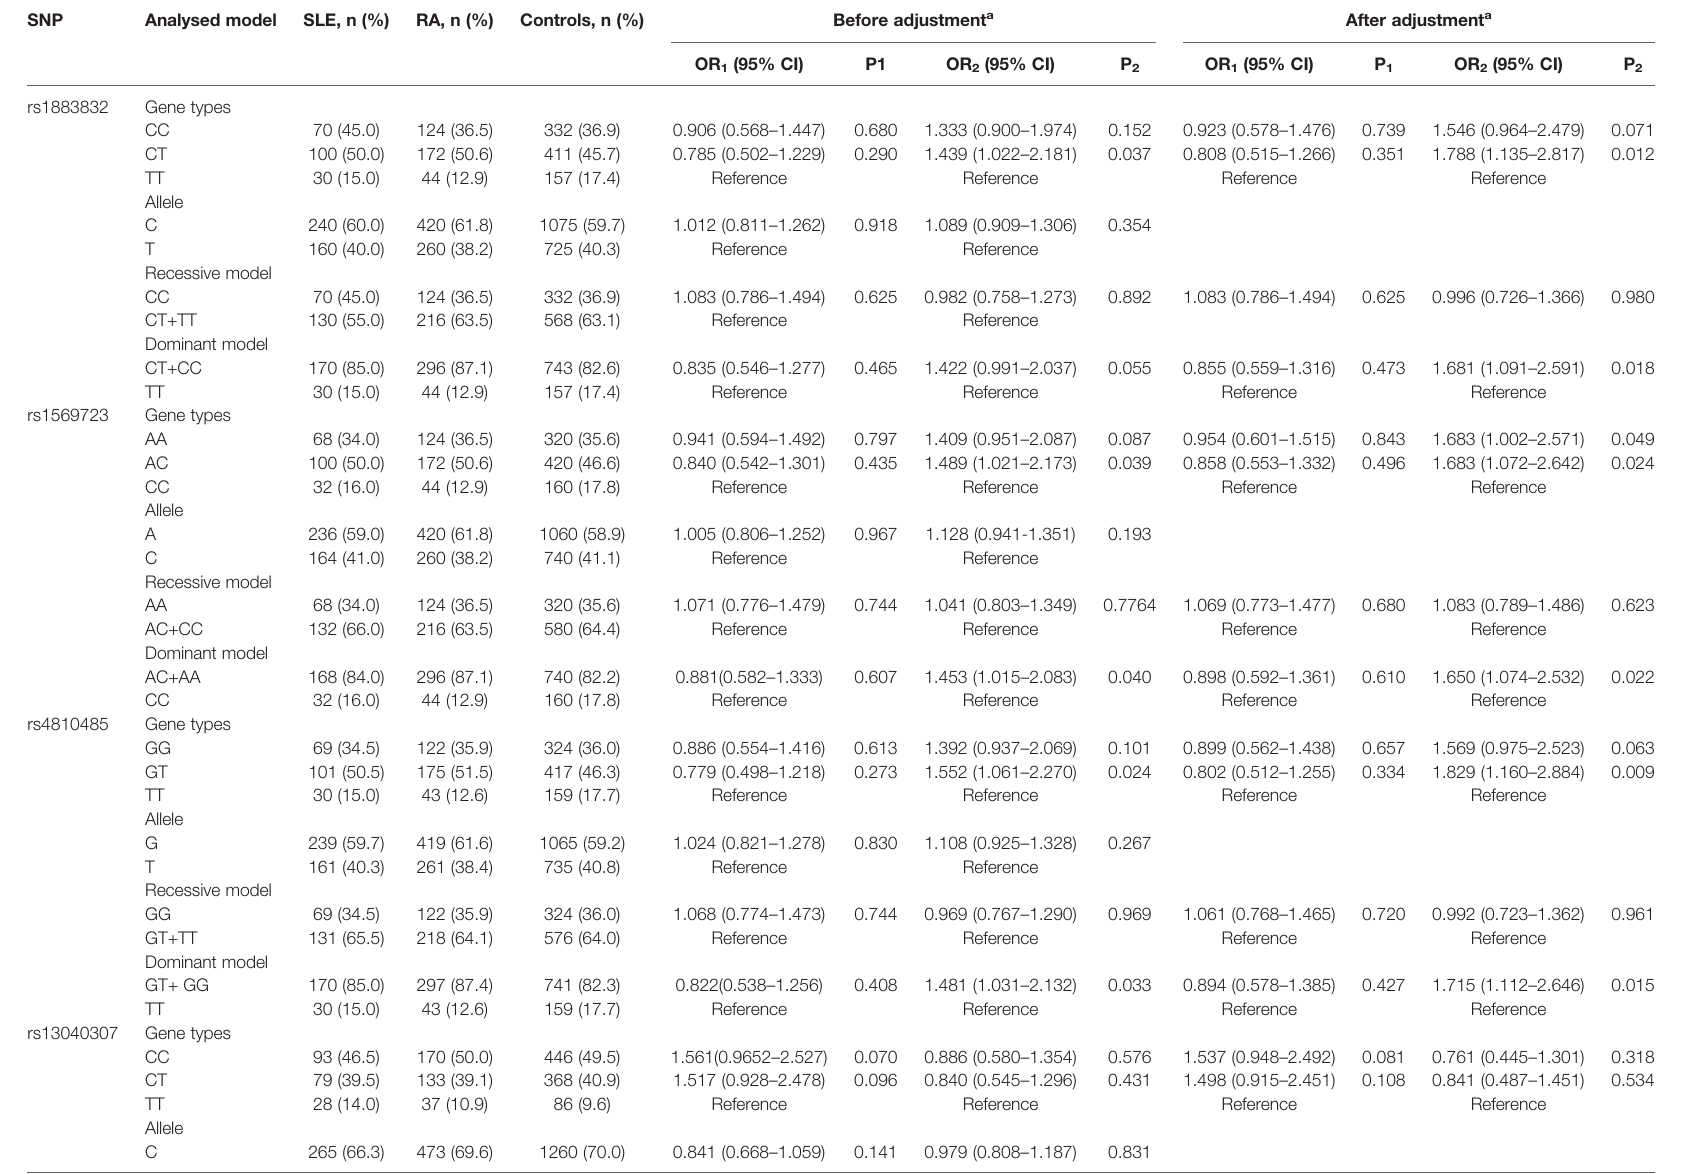
TABLE 2 | Allele and genotype frequencies of six polymorphisms in the CD40 gene in SLE patients, RA patients and healthy controls.